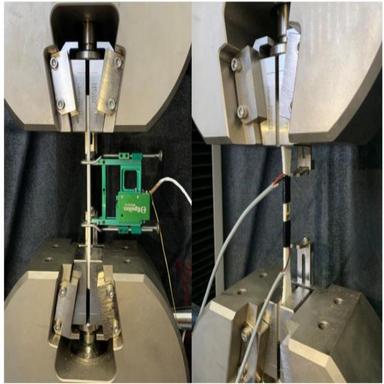
Static testing of elastic constants, including Young's moduli and Passion's ratios.